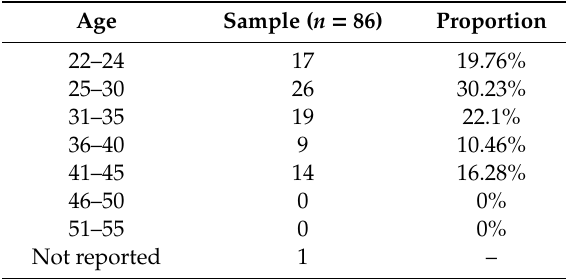
Table 2. Age distribution of sample for Study